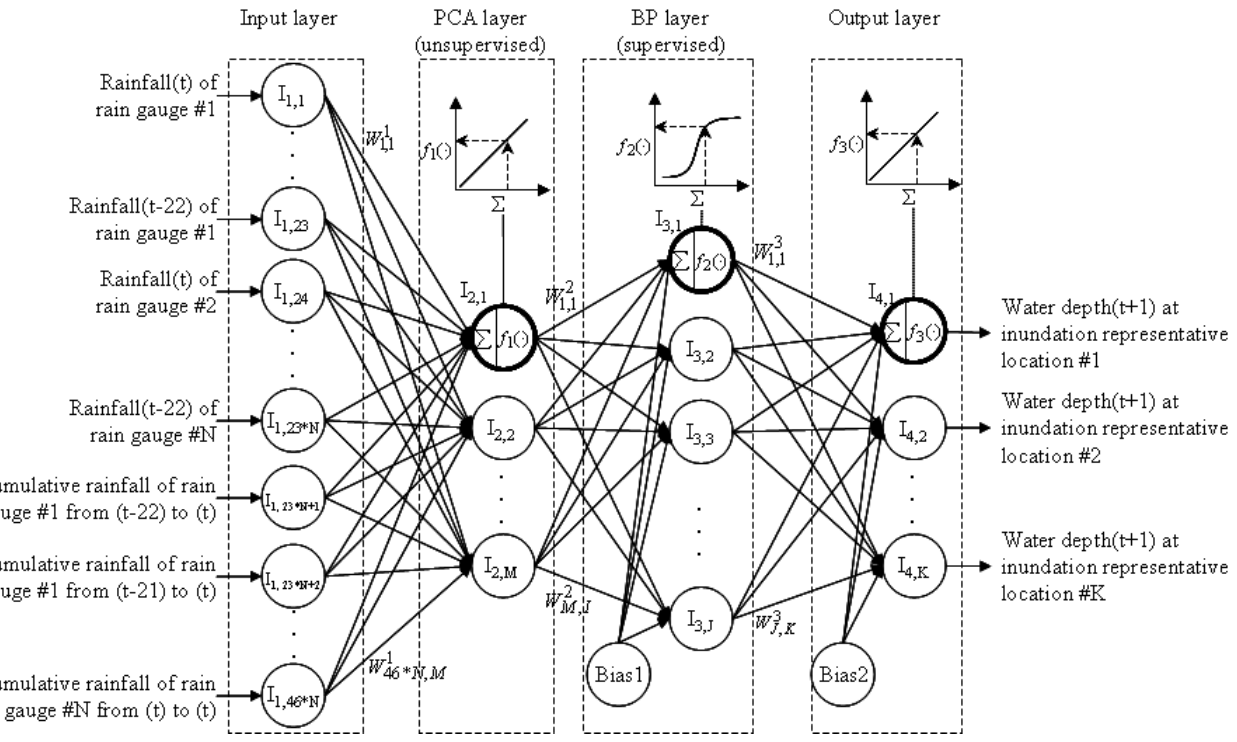
Fig. 1. Block scheme of the rainfall-inundation hybrid neural network. Each block represents a layer of neurons where N , M , J , and K denote the number of neurons, I , in each layer; N , M , and K also denote the number of rain gauges, principal components, and inundation- representative locations,